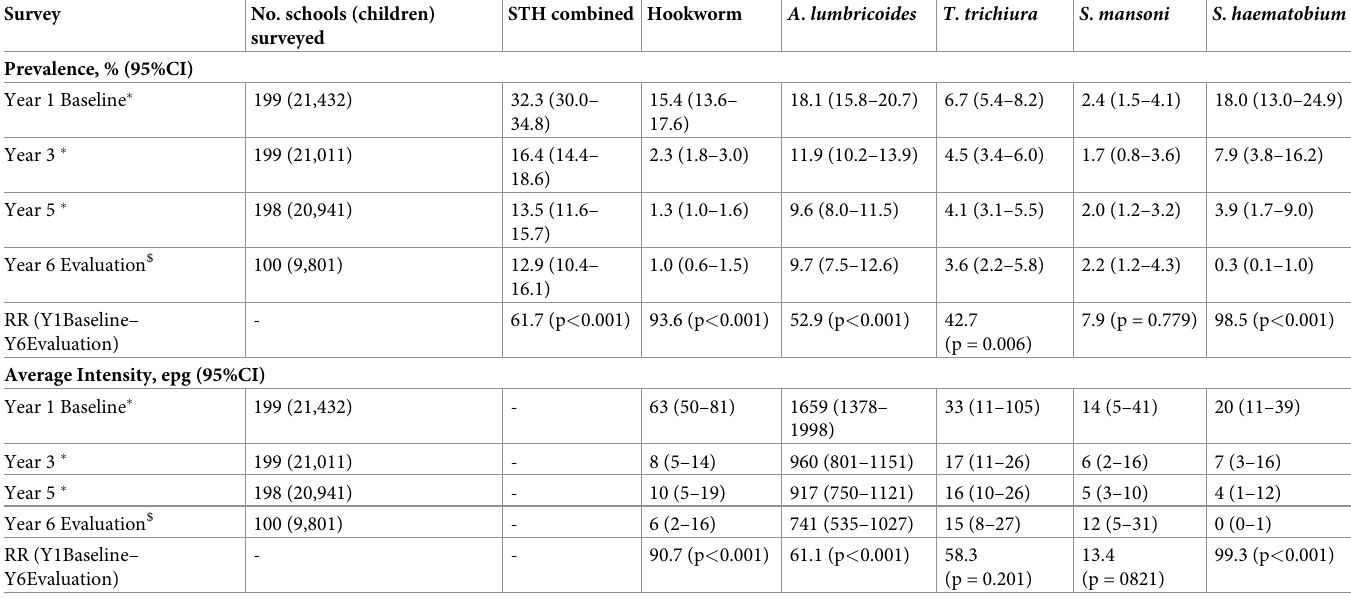
Table 2. Overall prevalence % (95%CI), mean intensity epg (95%CI) of infections and relative reductions (RR) % (p-value) among school children in Kenya after five rounds of MDA.